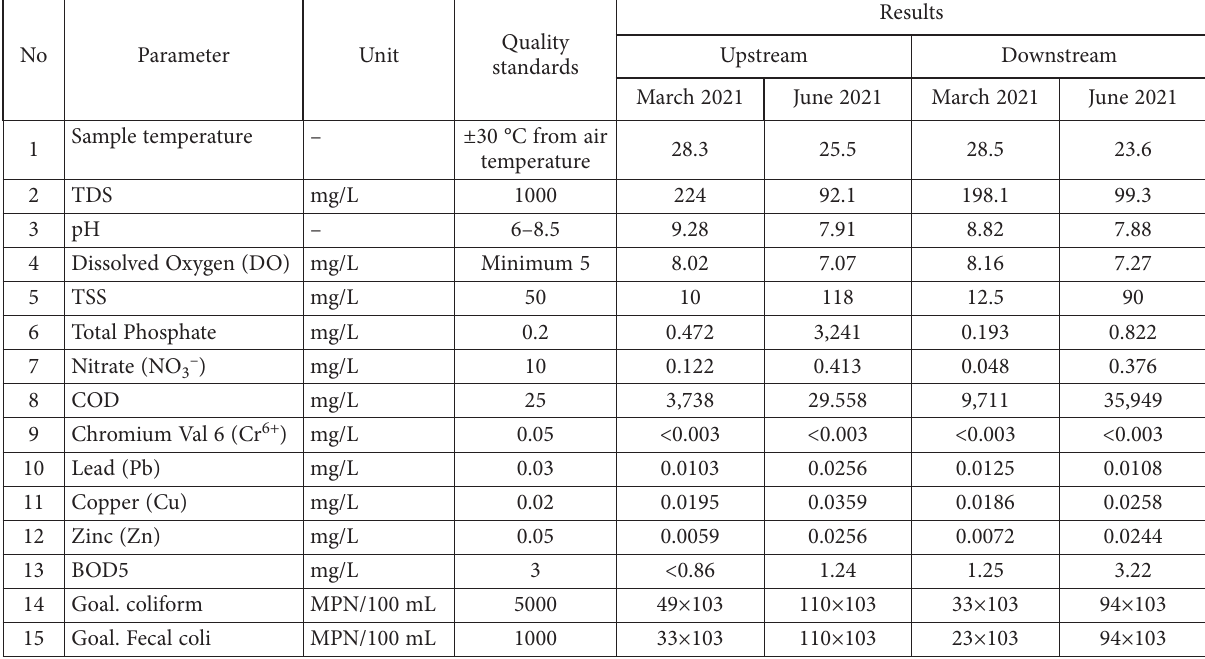
Table 4. Properties of surface water (Opak River) (source: Balai Pengelolaan Sampah, 2021)